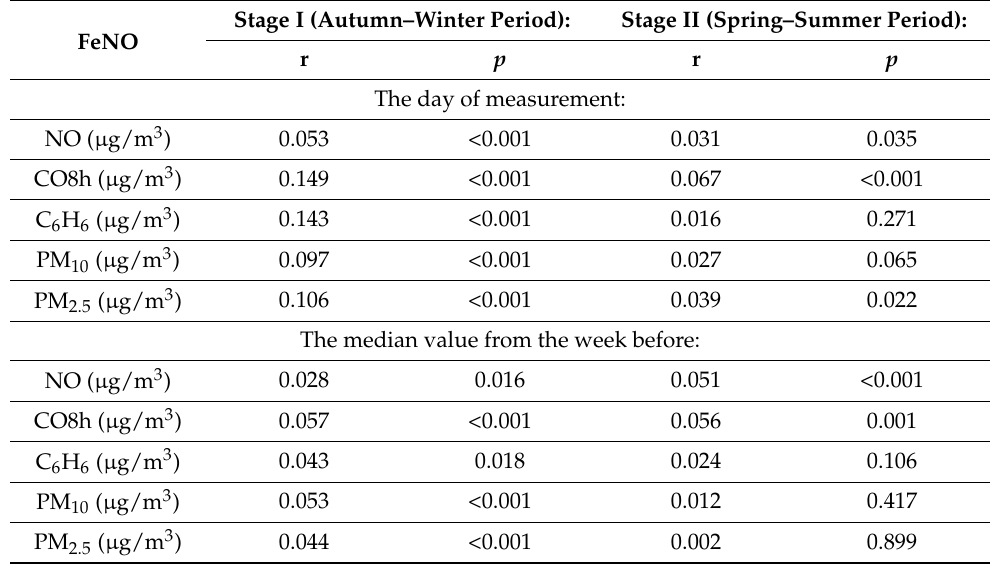
Table 3. Relationship between FeNO and air pollution in the study